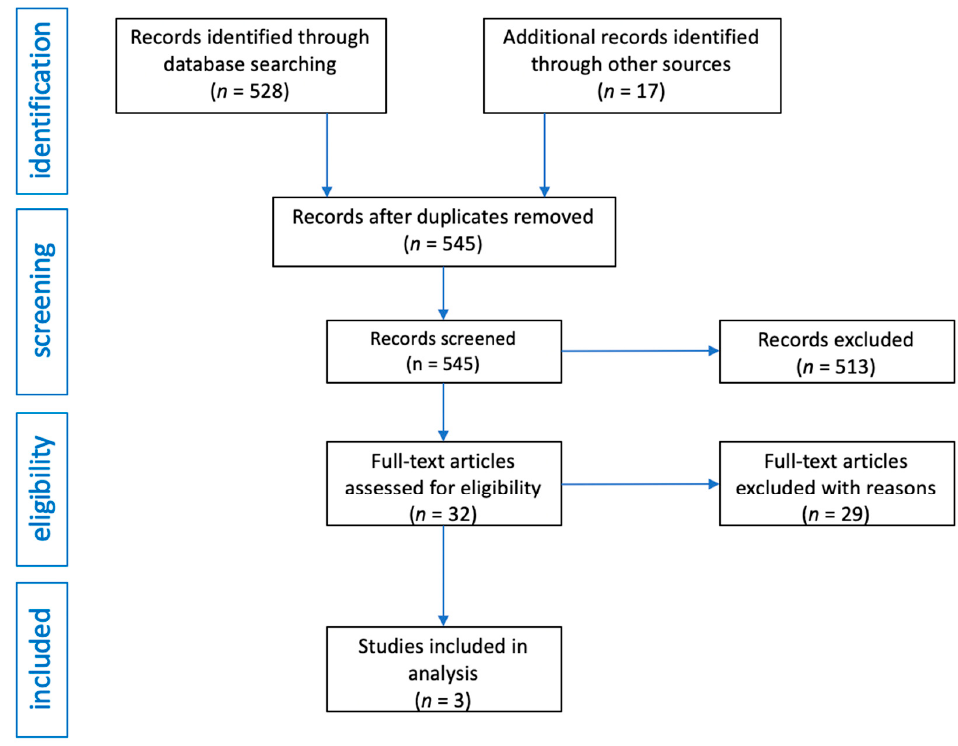
Figure 1. Flow diagram of studies analysis and selection for review.